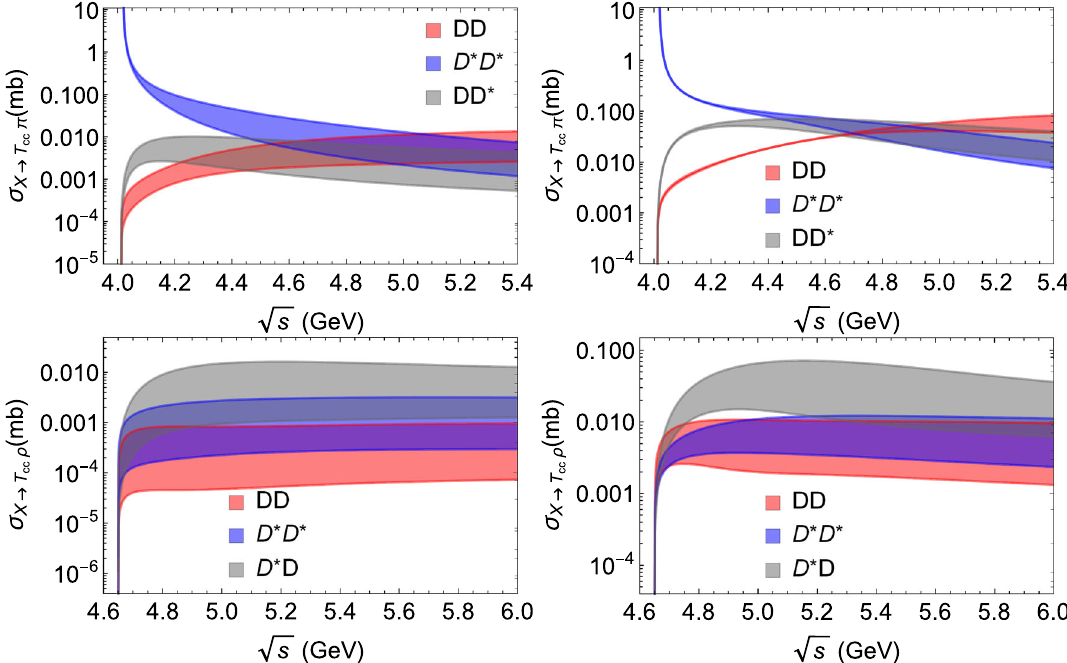
√ s for the respec- tively. Upper and lower limits of the band are obtained taking the upper and lower limits of the cutoff for each corresponding form factor (1– 2 GeV and 2.5–3.5 GeV for the monopole and Gaussian form factors,